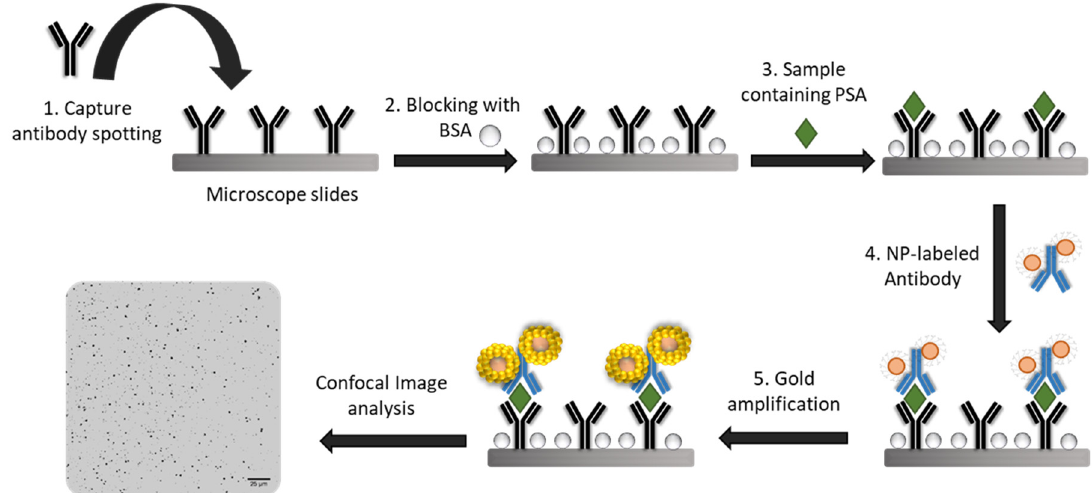
Figure 1. Schematic diagram of the nanoparticle (NP) ‐ based immunoassay strategy for the detection of prostate ‐ specific antigen (PSA) using catalytic deposition of gold on the surface of the NPs used as tags.